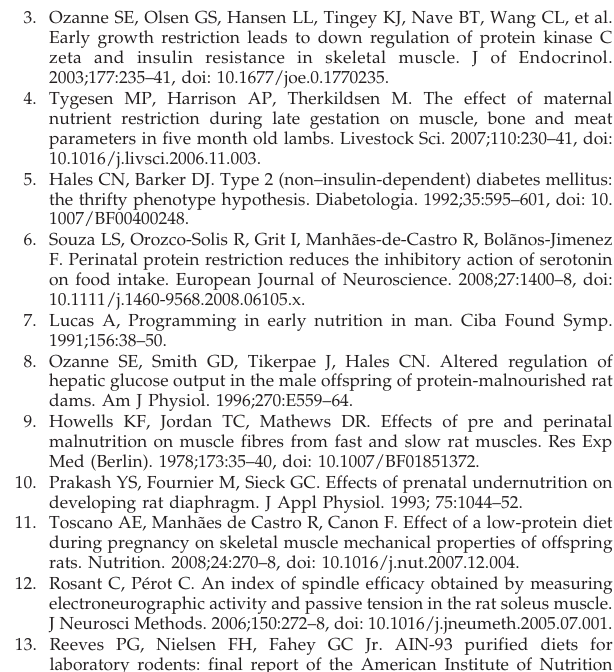
Figure 5 - Effects of undernutrition on tension at 125% L s (F 125 ), F 125 /PCSA, stiffness at 125% L s and tangent modulus in soleus and EDL muscles at 25 and 90 days of age induced by the stretch–release test. L s : slack length; PCSA: physiological muscle cross-sectional area; C: control group; UN, undernourished group. *p , 0.05